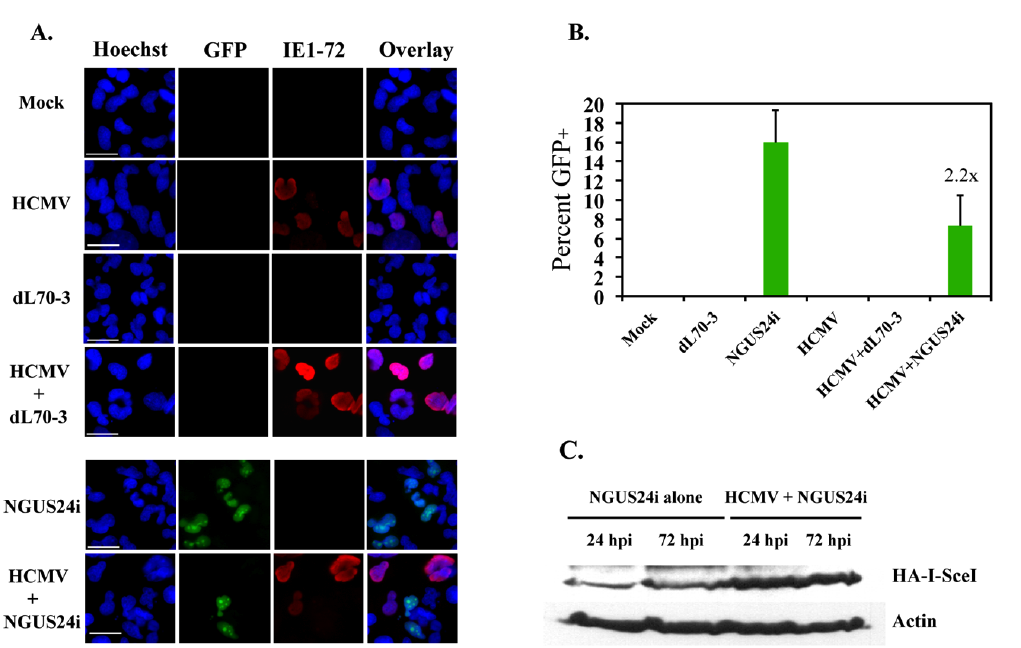
Figure 2. HCMV infection decreased HDR in T98Gs in the presence of stably integrated pDRGFP substrate. Cells were seeded onto glass coverslips and infected with HCMV or Ad individually or dually with HCMV and Ad in succession. Coverslips were harvested at 72 h post Ad superinfection with either I- Sce I expressing (NGUS24i) or control (dL70-3) virus. GFP + cells were scored as HDR competent. Clone 10 was stained by IF for the presence of IE72. ( A ) Representative IF staining for GFP + + IE72 + cells in Clone 10. ( B ) Percentage of GFP + cells in Clone 10 after infection. ( C ) Representative protein profile for steady state levels of HA-tagged I- Sce I in Clone 10 infected with NGUS24i alone or dually infected with HCMV and NGUS24i. Actin was used as a loading control. For IF studies at least 300 cells were scored for each type of infection. Values on top of the bar indicate fold decrease in percent of GFP + cells in dually infected versus NGUS24i alone experiments. Error bars represent one